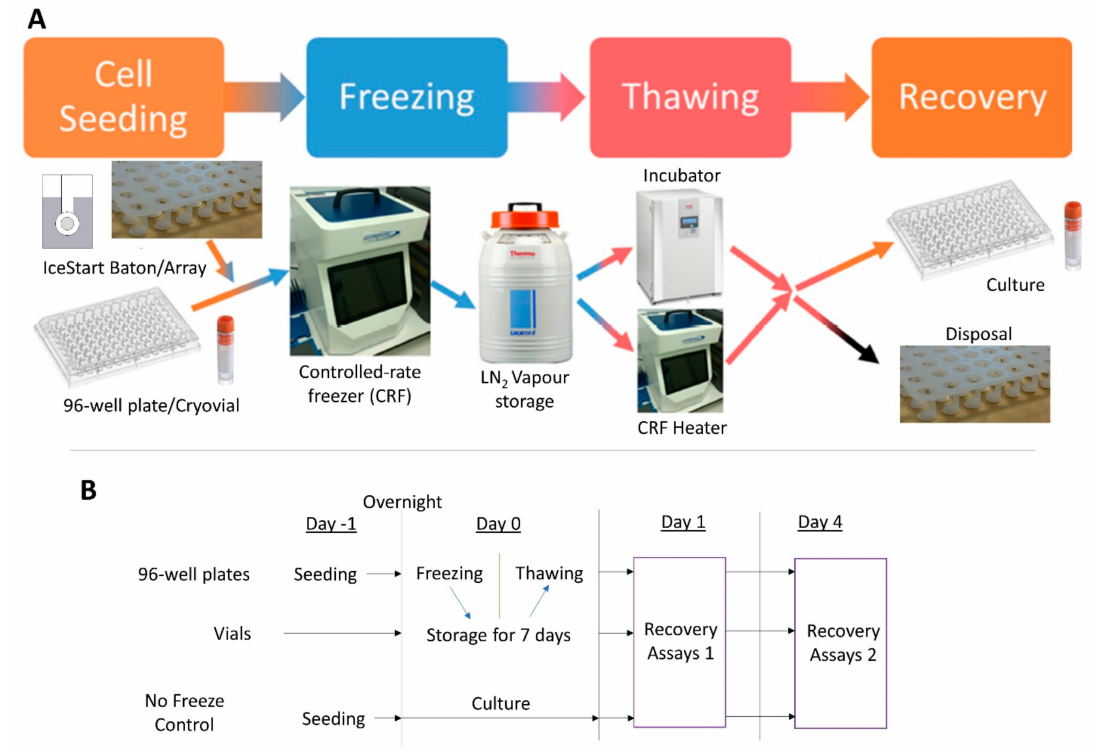
Figure 8. Experimental design schematic. ( A ) Cells are placed into vials or seeded into 96-well plates with cryostorage medium and ice nucleation devices (INDs). The cryovessels are then frozen in a controlled-rate freezer (CRF) before being transferred to liquid nitrogen (LN 2 ) for extended storage. The cells were then thawed using either an incubator or the CRF’s heating capability before culturing and assessment of recovery. ( B ) Timings schematic for cryostorage culture